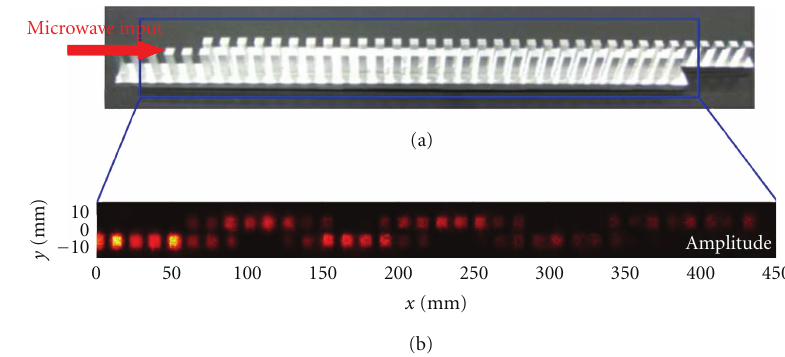
Figure 10: A spoof plasmonic waveguide guiding GHz waves [46], forming a directional